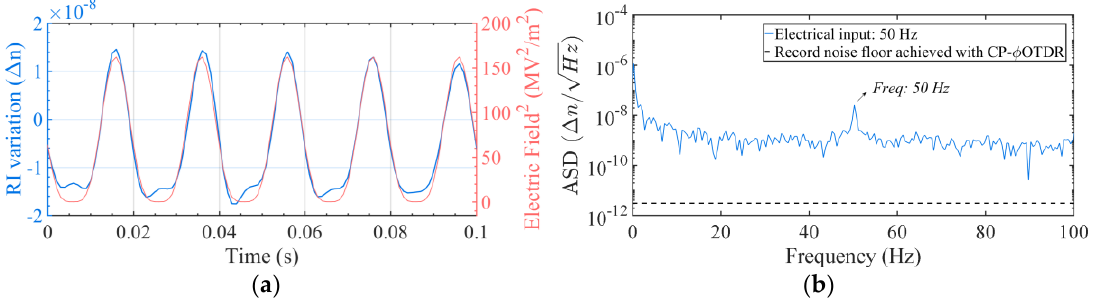
Figure 4. ( a ) Measured RI variation for a periodic electric field applied to a non-poled silica fiber at 50 Hz, represented in the time-domain (blue line); vs the applied signal (proportional to E 2 , varying between 0 V 2 /m 2 and ~161 MV 2 /m 2 ) applied to the fiber (red line). ( b ) Amplitude Spectral Density from the obtained RI signal (blue line). The record noise floor achieved with in CP-φOTDR in standard SMF is also represented (black dashed line) to contextualize the full potential of the technique [24], although it is not aimed at a direct comparison with the presented results.